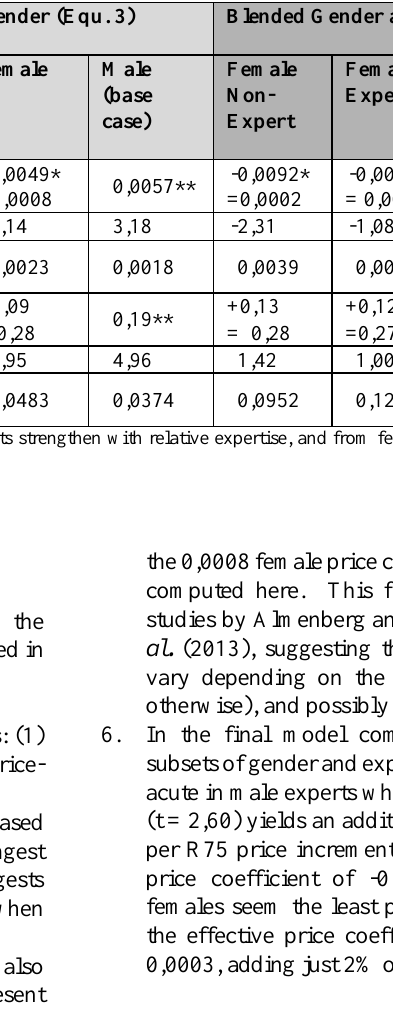
Table 4: Sight-based price and blind coefficients computed across the study models Sighted model type: